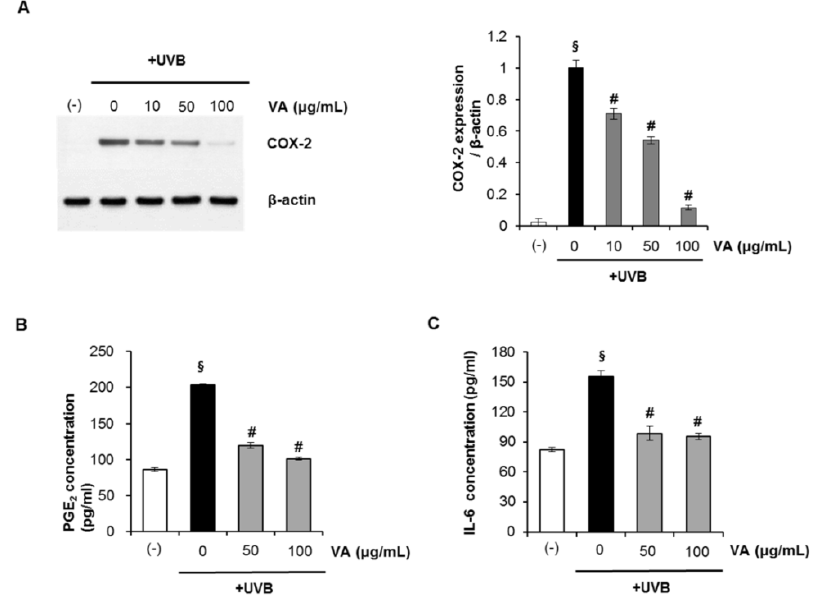
Figure 6. Veratric acid suppresses UVB-mediated inflammation cytokine production in human HaCaT keratinocytes. ( A ) Cyclooxygenase (COX)-2 protein expression. ( B ) Prostaglandin-E (PGE ) and ( C ) Interleukin-6 (IL-6) concentrations in cell culture 2 2 superantants.